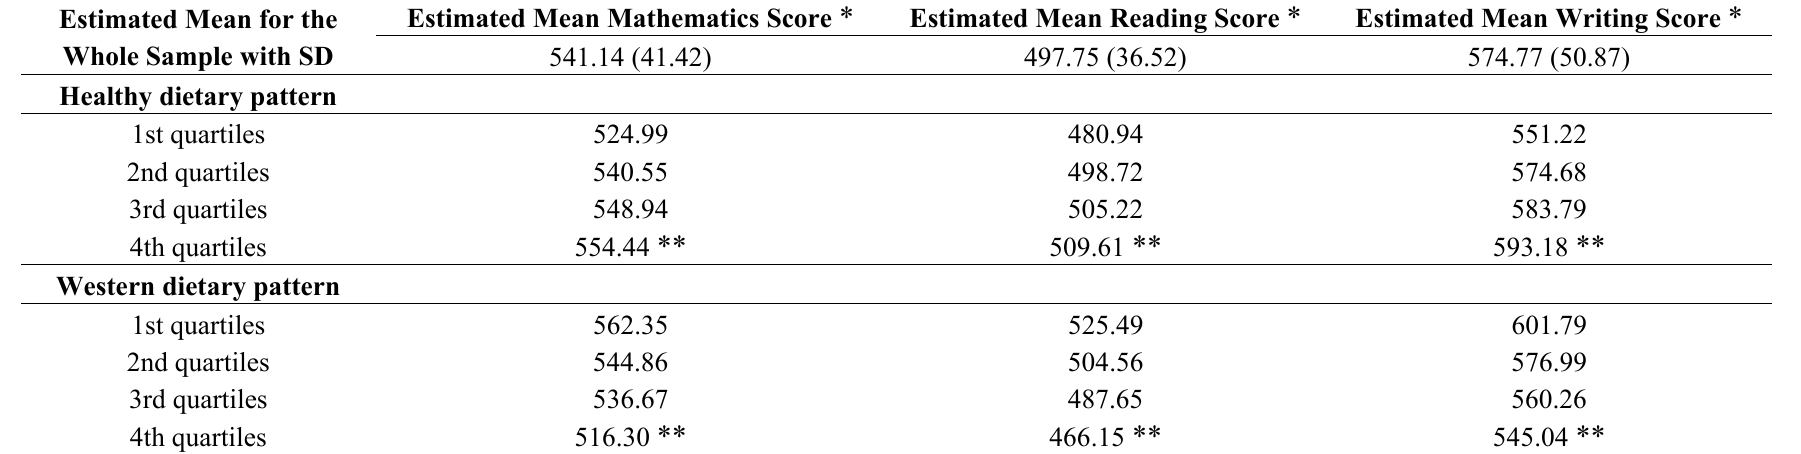
Table 4. Estimated means (from predicted values of multivariable regression models) of academic scores for the quartiles of Western and Healthy dietary patterns scores in the Western Australian Pregnancy Cohort (Raine) Study at 14 years of